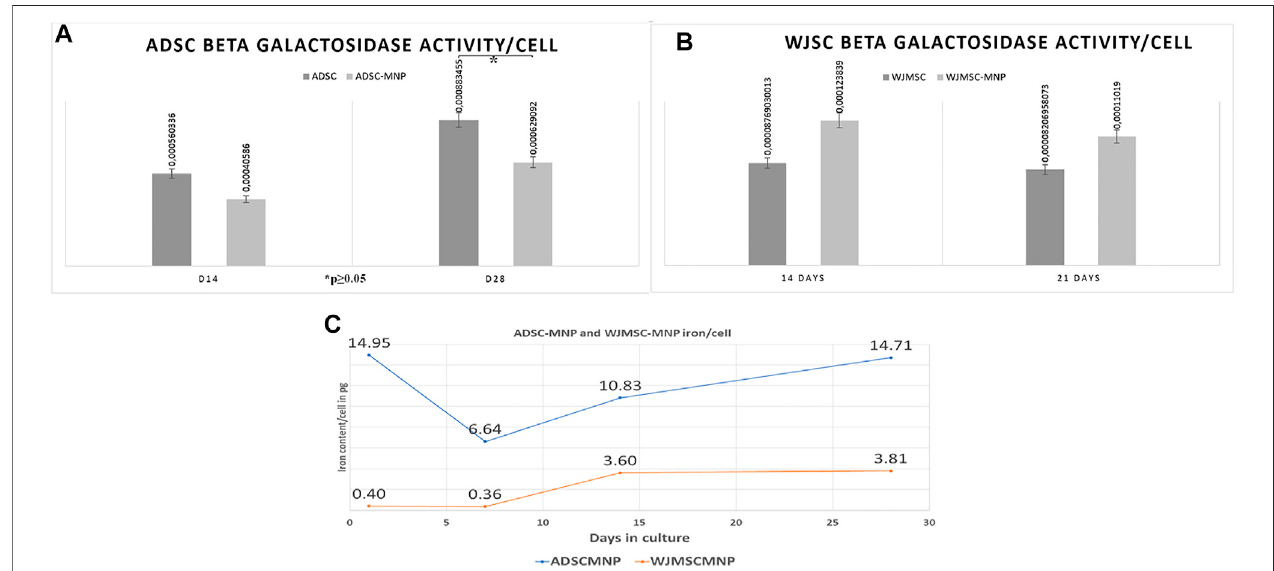
FIGURE 3 | Beta galactosidase activity (B-Gal) in ADSC (A) and WJMSC (B) demonstrating signi fi cant less enzymatic activity in ADSC-MNP at 28 days in culture comparedtoADSCatsametimepoint (C) ;ironcontent/cell(inpicograms)at1,7,14and28 dayscell-particleinteraction;after24 hcellparticleinteractionADSCaquire enough iron content to become remote controllable within MF (14, 0